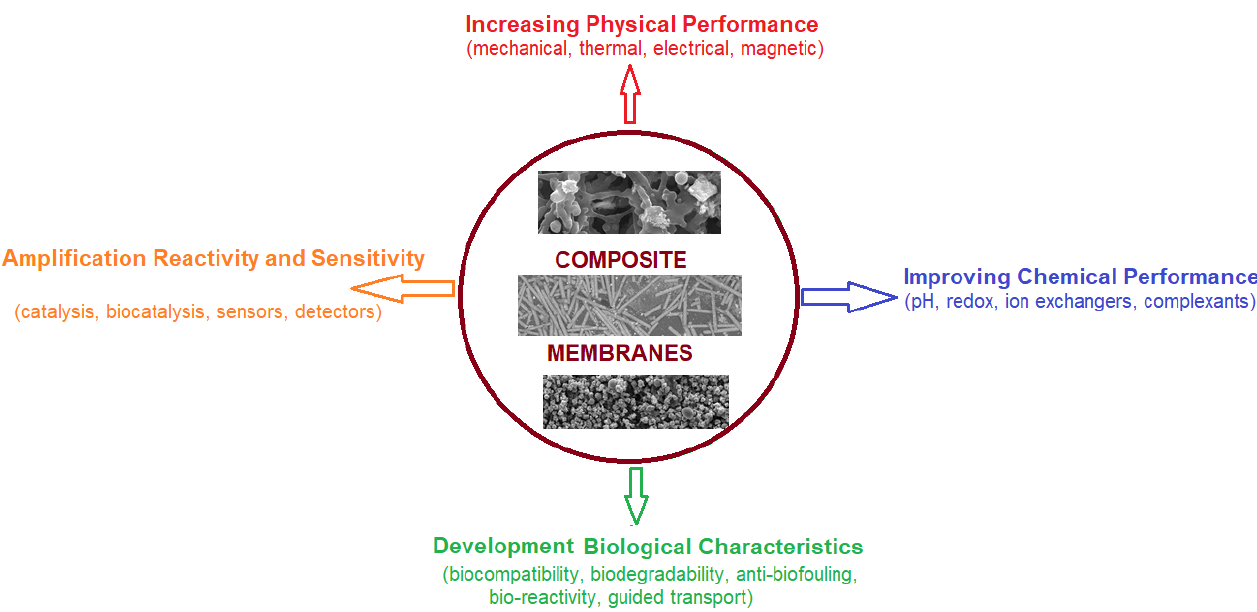
Figure 1. Composite membranes based on nanoparticles and the specific effects.